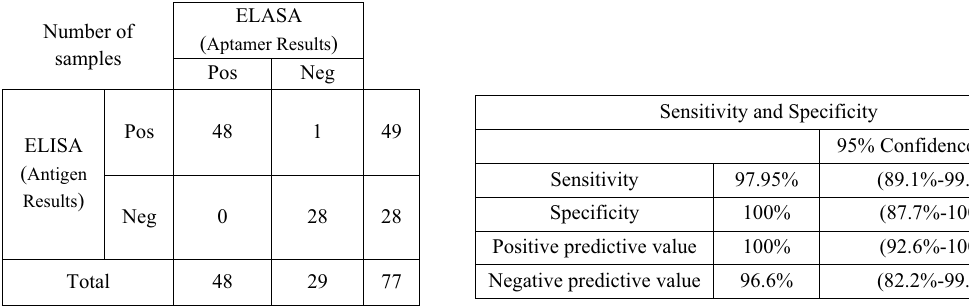
Table 2. Sensitivity and specificity of the ELASA method in comparison with standard antigen ELASA